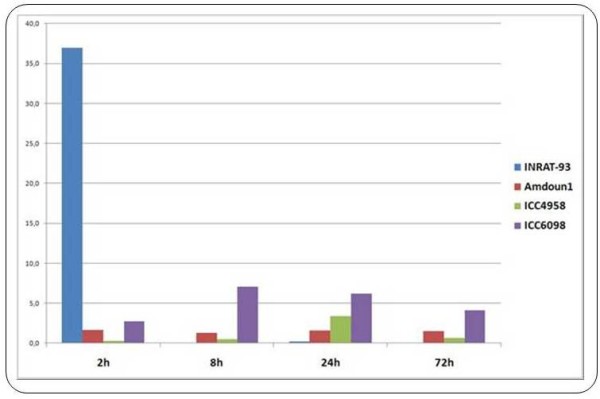
Relative expression levels of AOS-annotated transcripts in four chickpea varieties at different time points after salt stress onset, measured by qRT-PCR. The expression level of the INRA-93 derived 26 bp tag STCa-13267, annotated to an allene oxide synthase (AOS), was determined in the salt-tolerant chickpea variety (INRAT-93) and compared to less tolerant varieties. According to deepSuperSAGE, the AOS-annotated transcript is slightly (1,6-fold) down-regulated 2 h after stress, but the relative expression level remains very high when compared to the one of the salt-sensitive varieties. At subsequent time points, the AOS-expression decreases drastically in INRAT-93, whereas the levels in the salt-sensitive varieties remain constant.